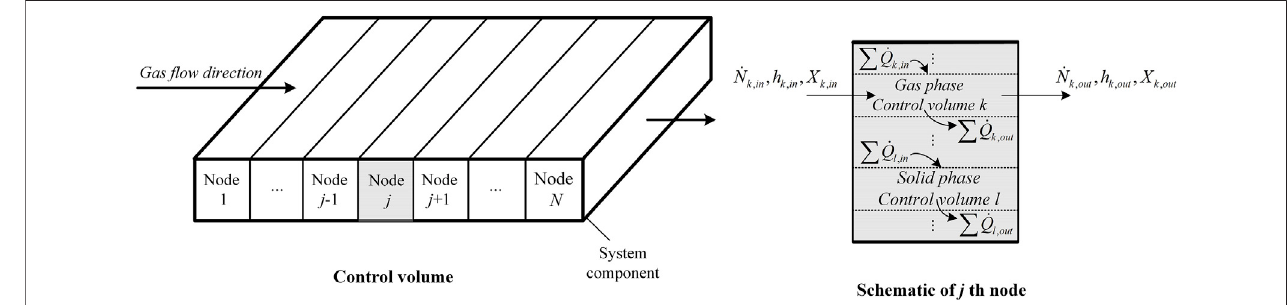
FIGURE 3 | Nodes and control volumes of the 1D model.